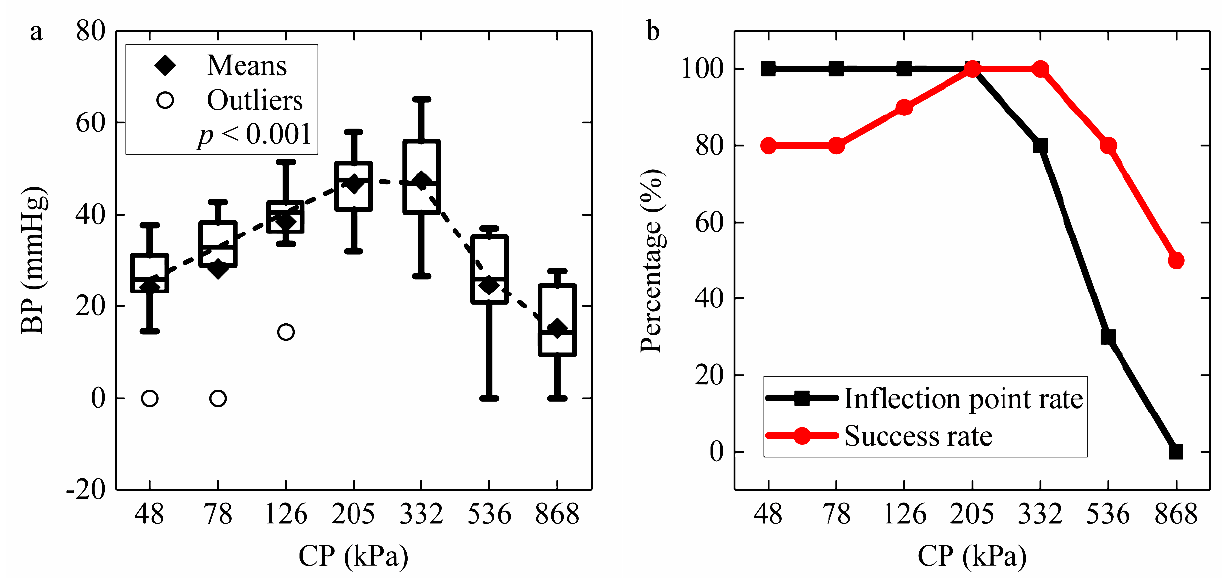
Figure 13. ( a ) Bursting pressure (BP) results and ( b ) inflection point rate and success rate under seven levels of compression pressure (CP). BPs under 205 kPa and 332 kPa are better than those under other CP levels. The optimal CP range for achieving the best anastomosis is 205 kPa to 332 kPa. The inflection point rate is defined as the number of inflection points per total number of experiments. The inflection point rate is higher than the success rate below 205 kPa but lower than over 205 kPa. Under the appropriate pressure of 205 kPa, the inflection point and success rates would increase to 100%. The dynamic impedance inflection point may be equivalent to successful welding and definite weld strength.